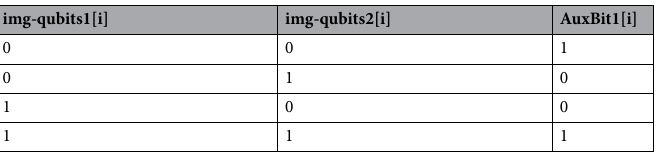
Algorithm 2 Compare the similarity between two grey quantum images with a grey range of 2 q .